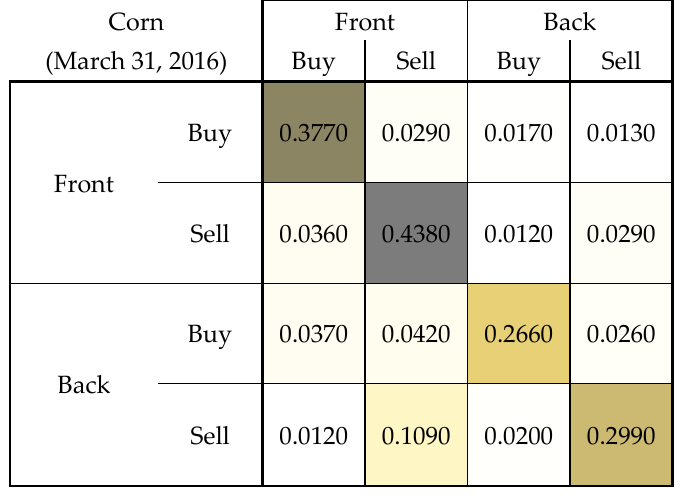
Figure 4. Estimated matrix of kernel norms for corn on 31 March 2016.